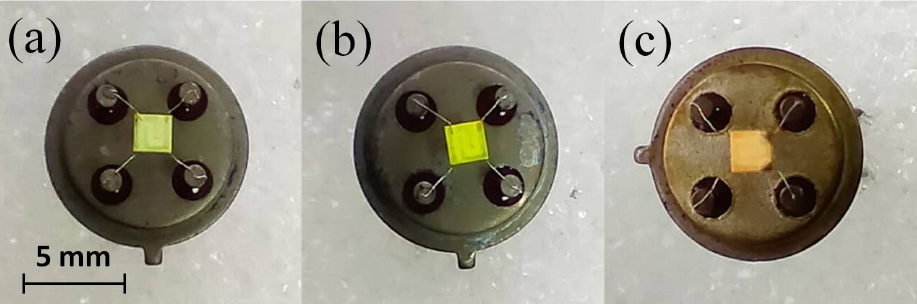
Figure 2. Images of ZnO/CsPb(Br/Cl) 3 ( a ), ZnO/CsPbBr 3 ( b ) and ZnO/CsPb(I/Br) 3 ( c ) photocon- ductive nanocomposites formed on the measuring aluminia plates with Pt